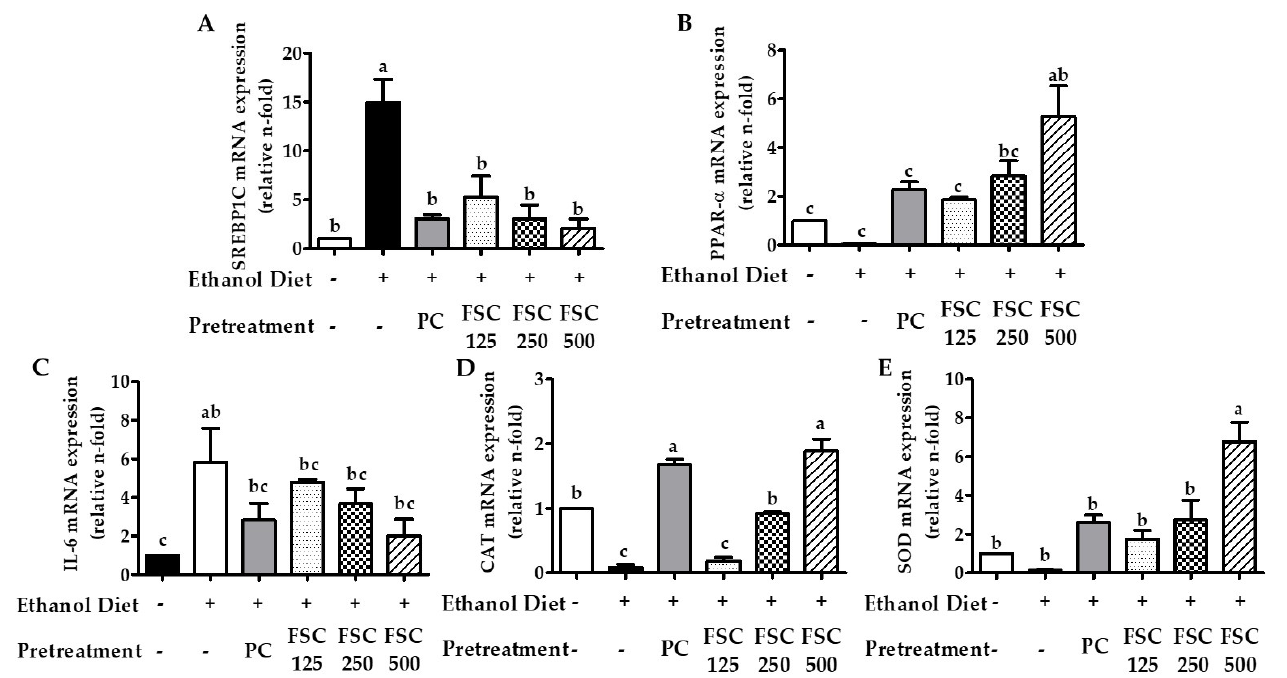
Figure 6. Effect of FSC on the mRNA expression of lipid metabolism-associated enzymes ( A , B ), inflammatory cytokine ( C ), and antioxidant enzyme ( D , E ) in rats with chronic alcohol consumption. Group ND, water (normal diet); Group NC, ethanol diet only (negative control); Group PC, HDE + ethanol diet (positive control); Group FSC 125, 125 mg/kg b.w. FSC + ethanol diet; Group FSC 250, 250 mg/kg b.w. FSC + ethanol diet; Group FSC 500, 500 mg/kg b.w. FSC + ethanol diet. The relative mRNA expression levels were determined by RT-PCR. Data represent the mean ± SEM (n = 6). Bars with different letters show significant differences between groups ( p < 0.05) determined by analysis of variance and Tukey’s multiple comparison